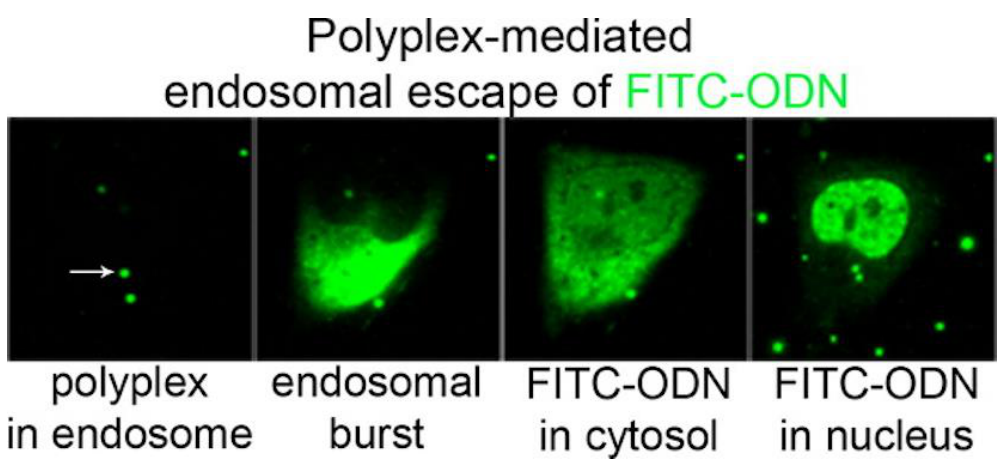
Figure 10. PEI-mediated cytosolic delivery of oligonucleotides occurs by endosomal bursting. HeLa cells were incubated with polyplexes carrying fluorescein isothiocyanate labeled oligo-deoxynucleotides (FITC-ODNs) in green and monitored by time-lapse microscopy. Following internalization of the poly (ethylene imine) (PEI) polyplexes in endosomes, endosomal bursting occurs causing the release of ODNs into the cytosol. After an initial appearance throughout the cytosol, the ODNs rapidly accumulate in the nucleus. Reprinted from [165] with permission from 2013 American Chemical Society.